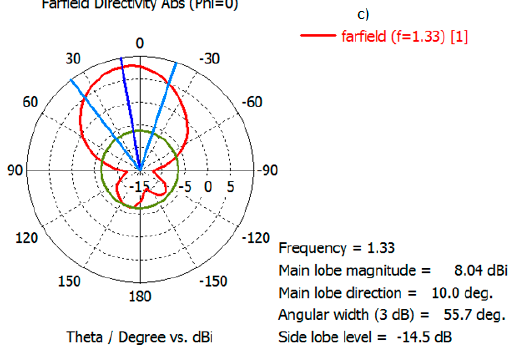
Figure 15. Results obtained with FR-4 for 5°.